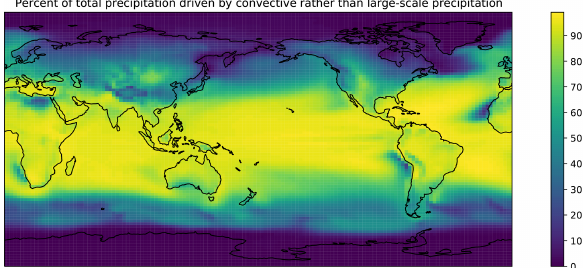
Figure A7. The percent of total precipitation in each grid cell in the control simulation that is derived from convective precipitation as opposed to large-scale precipitation is shown.